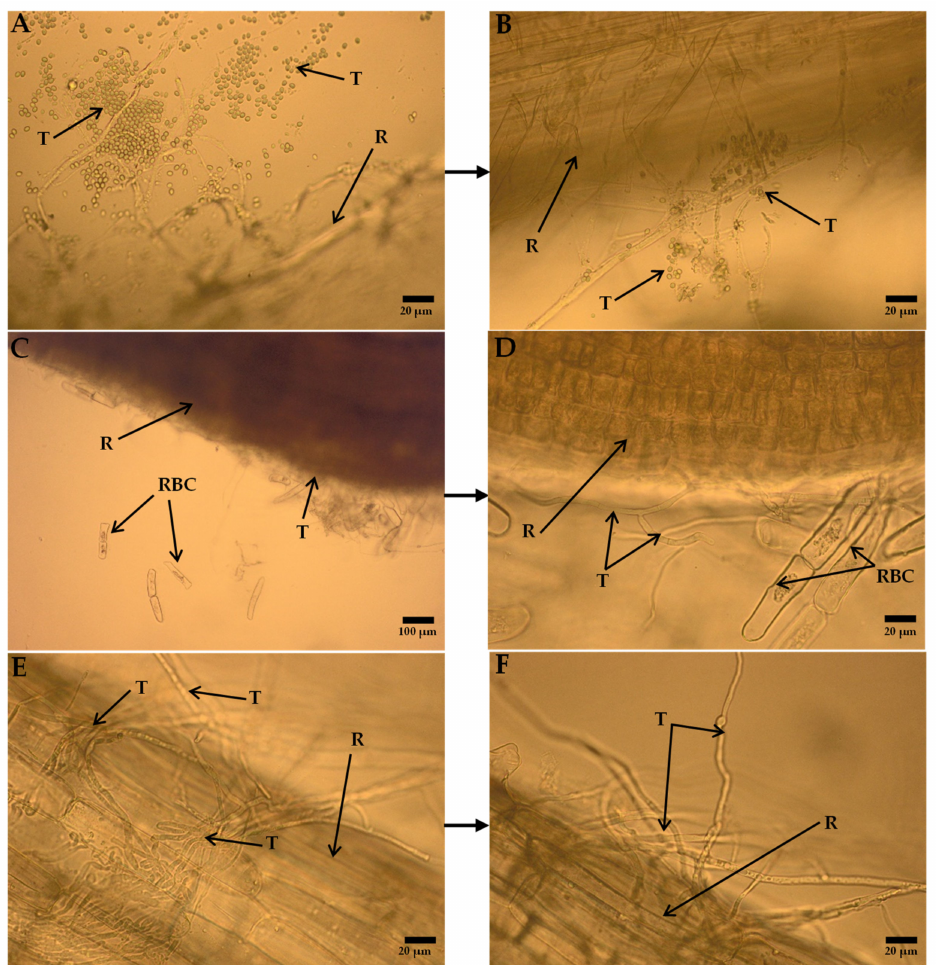
Figure 13. The LM micrograph of wheat seedling root colonization in hair root and RBC zone: Trichoderma DEMTkZ3A0 strain conidia germinated on root surface 5-day after inoculation ( A , B ); hyphae of Trichoderma DEMTkZ3A0 strain along root surface, root hairs and around root border cells (RBC) 10-day after inoculation ( C , D ); intensive mycelial growth of Trichoderma DEMTkZ3A0 strain on root surface 10 days after inoculation ( E , F ). Abbreviations: T— Trichoderma DEMTkZ3A0 strain hyphae or conidia; R—wheat root; RBC—root border